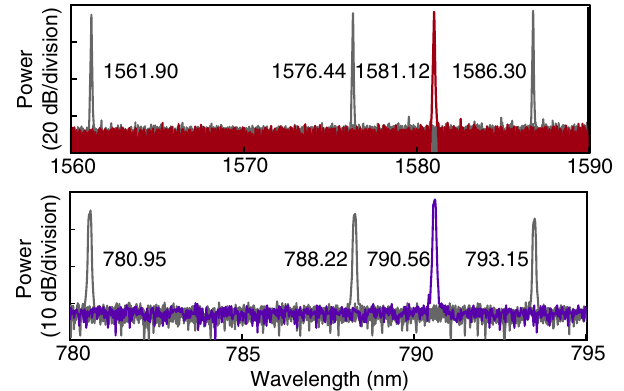
Fig.8|Opticalspectraofthefundamental-frequencylasingmode(top)andthe up-converted light at the second harmonic (bottom). The measured signal at different wavelength of fundamental-frequency lasing mode (top) and generated second-harmonic mode (bottom) from the same device, indicating a dual lasing bandwidth over 10nm at visible